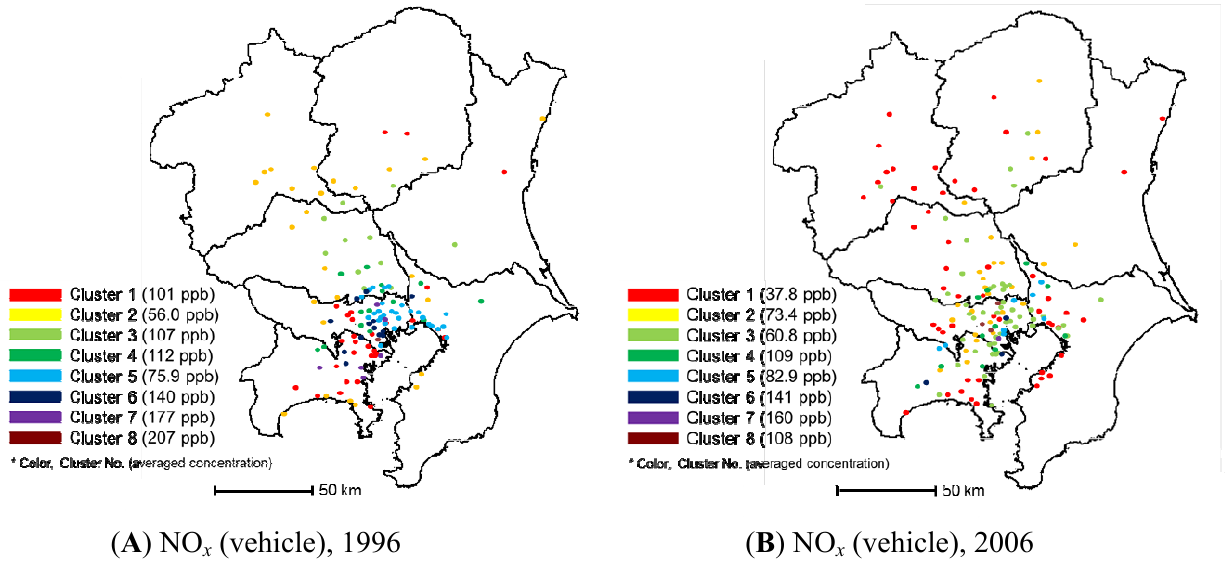
Figure 4 Results of clustering using NO monitoring stations: ( A ) in 1996 and ( B ) in